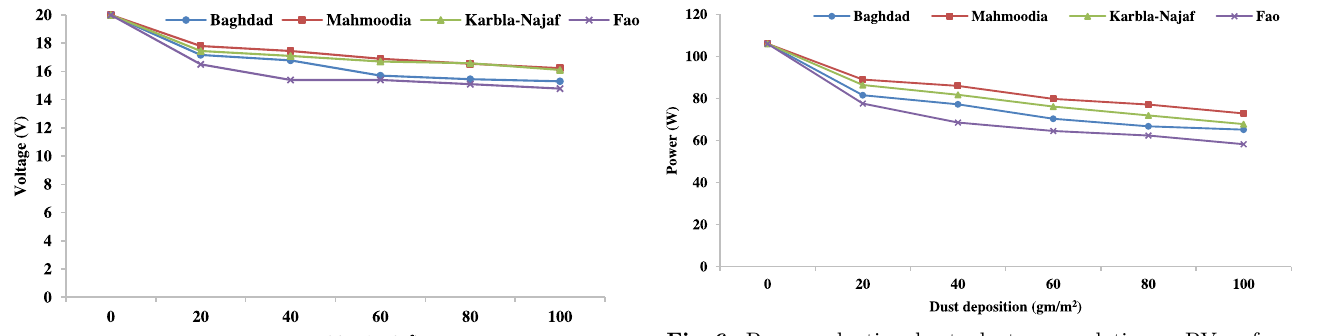
Fig. 7. Dust accumulation effect on P polluted / P clean